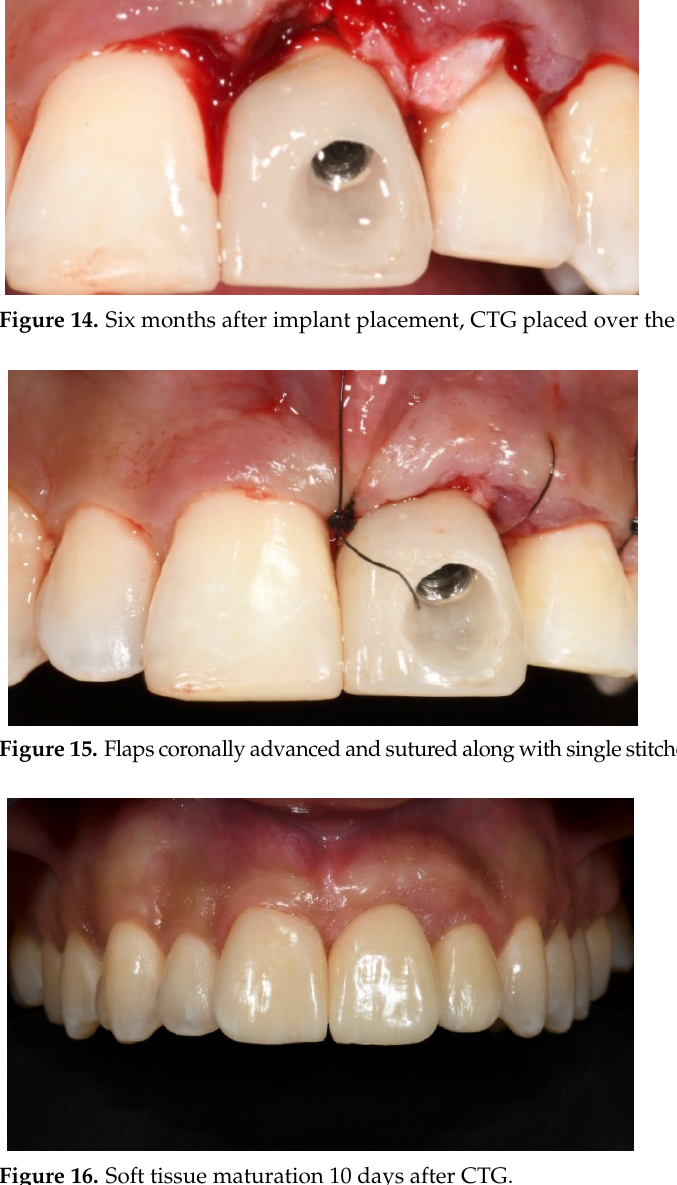
Figure 16. Soft tissue maturation 10 days after CTG.